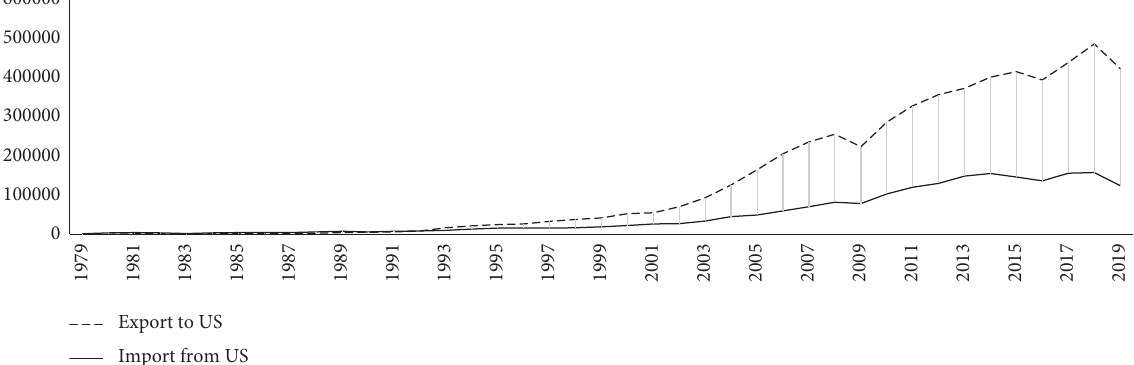
Figure 6: China’s trade with the United States (1979–2019). Source: the IMF direction of trade statistics